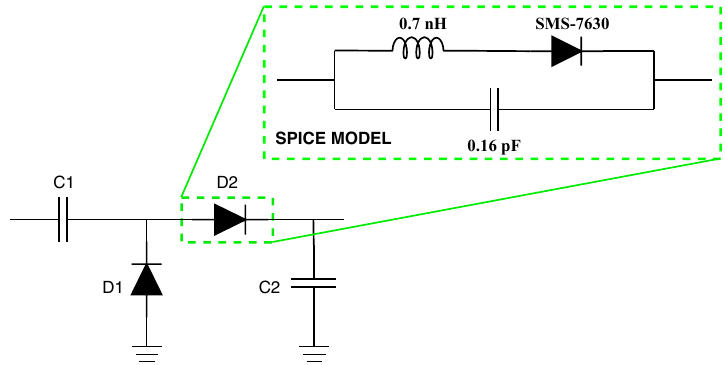
Figure 3. Diode circuit and simulation program with integrated circuit emphasis (SPICE)